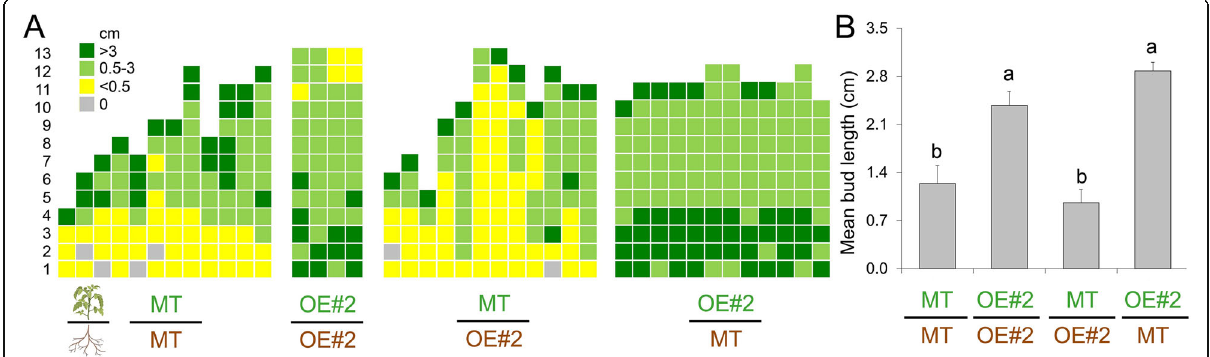
Fig. 2 Increased shoot branching in CKX2-overexpressing plants is not caused by a root-derived signal. A. Schematic representation of axillary shoot branching of grafted genotypes at anthesis. B . Mean bud length of CKX2-OE#2 (here described as OE#2) and MT plants. Data are means ± SE . Different letters indicate significant differences (Tukey test, P < 0.05) among grafted